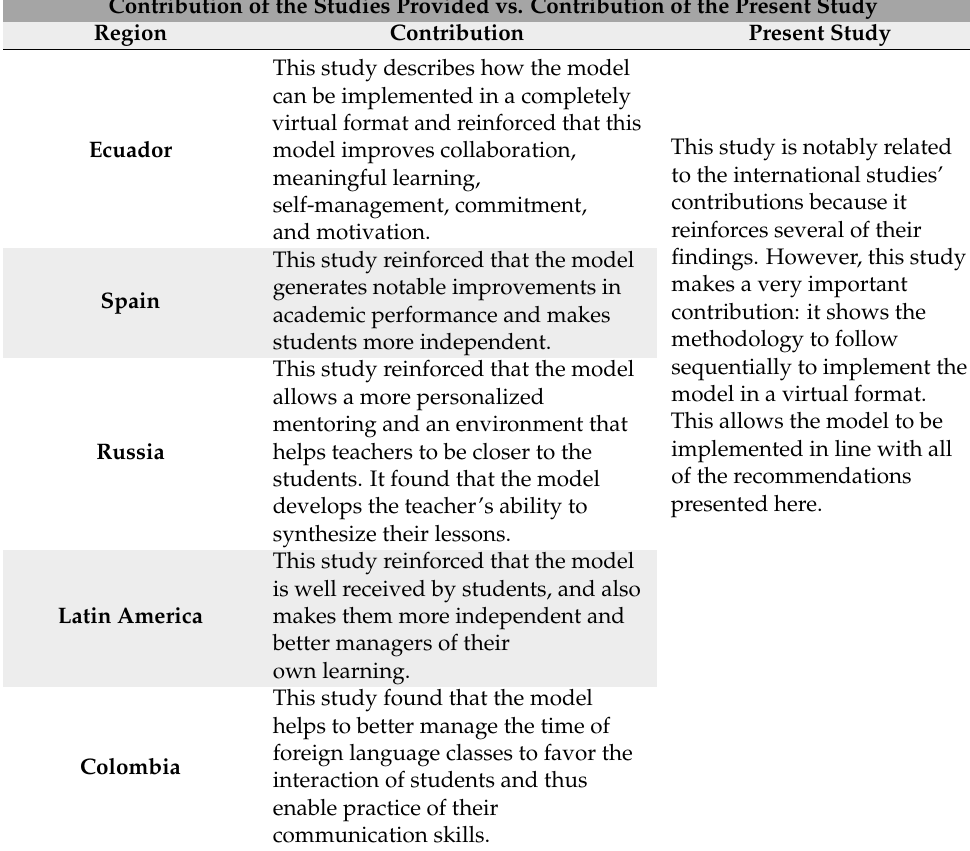
Table 2. Contribution of the studies provided vs. contribution of the present study regarding the application of the Flipped Classroom